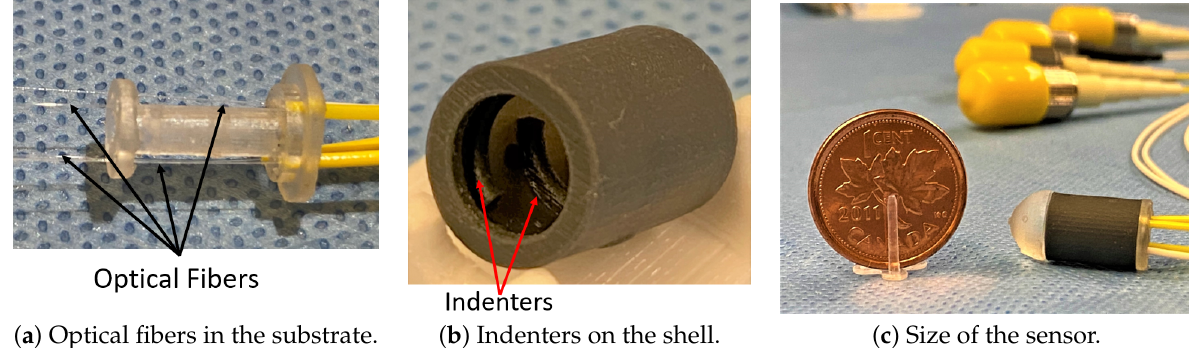
( a ) Optical fibers in the substrate. ( b ) Indenters on the shell. ( c ) Size of the sensor. Figure 8. ( a ) A 3D printed rigid substrate and four inserted optical fibers, ( b ) 3D printed shell and indenters on its bottom surface using Formlabs flexible resin, ( c ) assembled structure of the cylindrical sensor in comparison with a coin, the cap is attached to show the final shape of the sensor with reflective surface suitable for TAVI